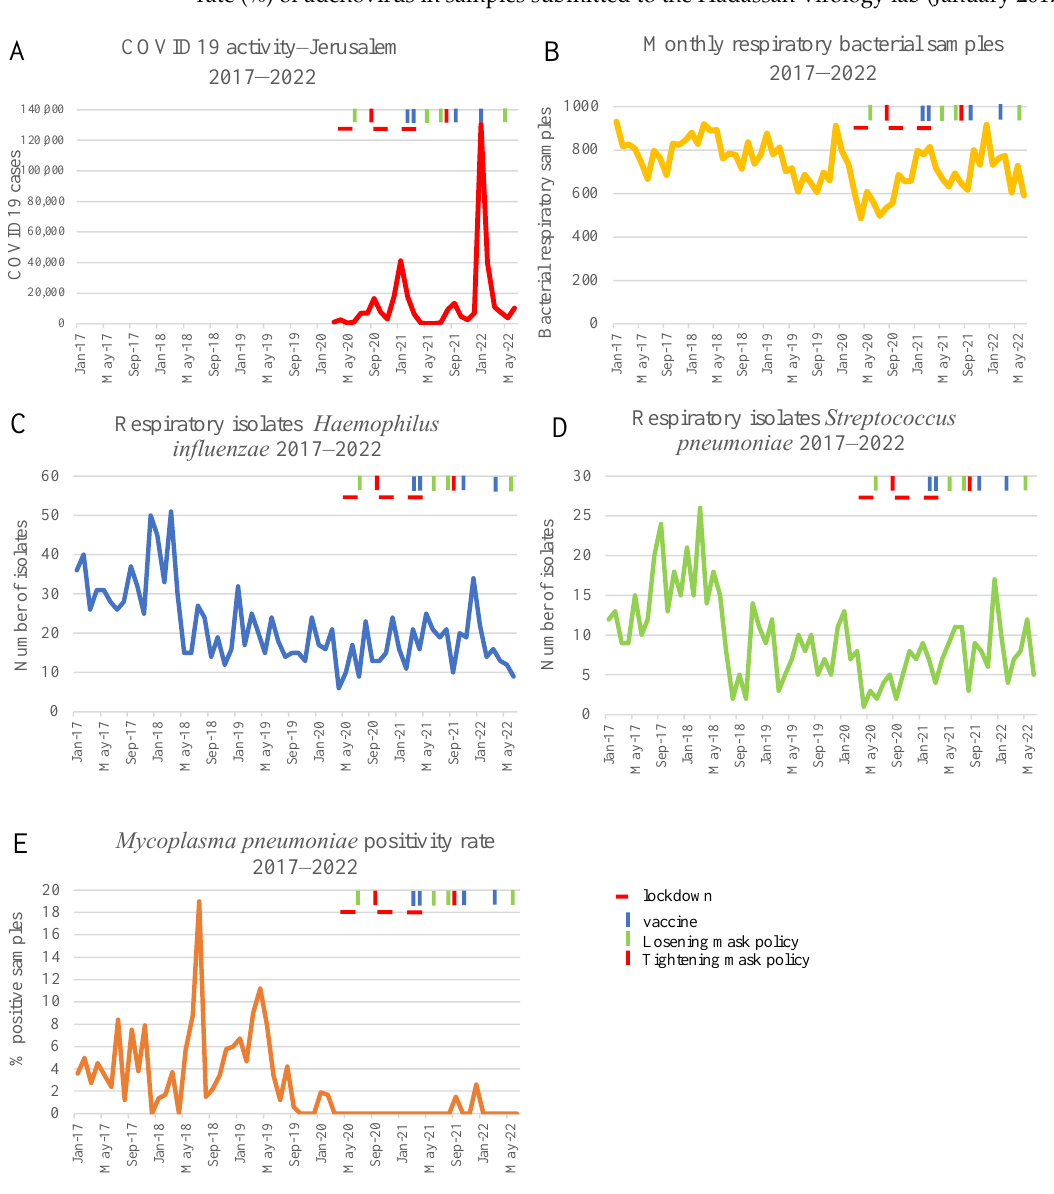
Figure 2. Bacterial pathogens in the pre-COVID-19 and during the COVID-19 pandemic. ( A ). COVID-19 activity − Monthly COVID-19 cases in Jerusalem district. ( B ). Monthly sputum samples